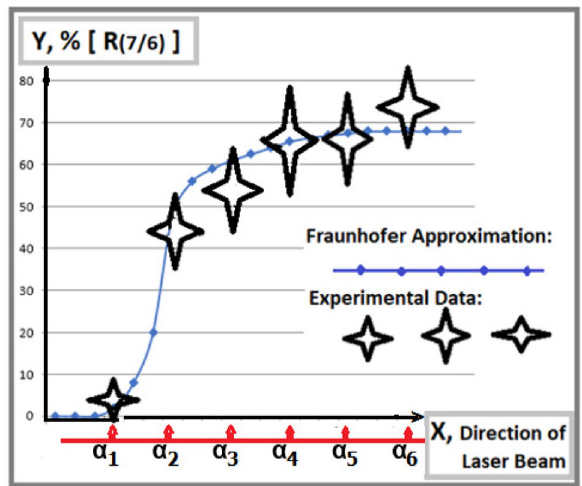
x 1 to their neighbors vice-versa horizontal directions of the = ± I ( min . )/ I ( 6 ) with Fraunhofer approximation =